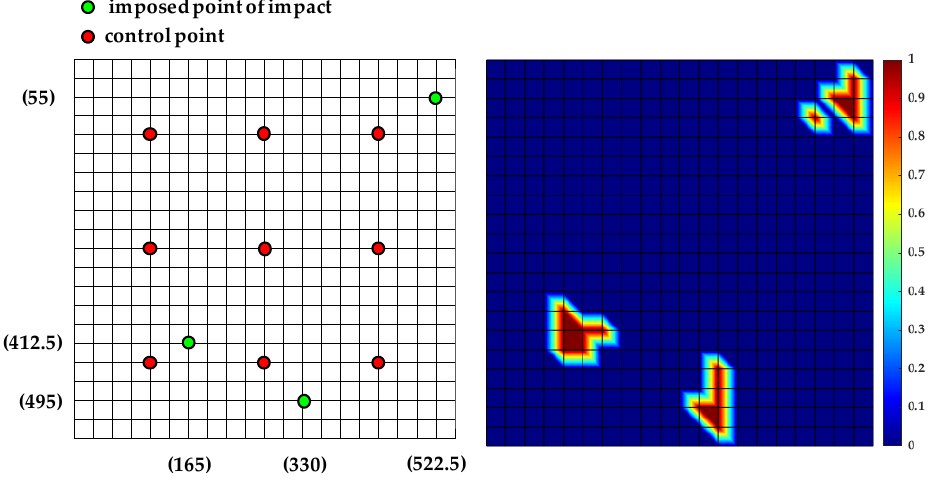
Figure 11. Impact position detection on experimental test-based ANN: verify of geometric coordinates (x, y): (165, 412.5), (330, 495), and (522.5, 55).